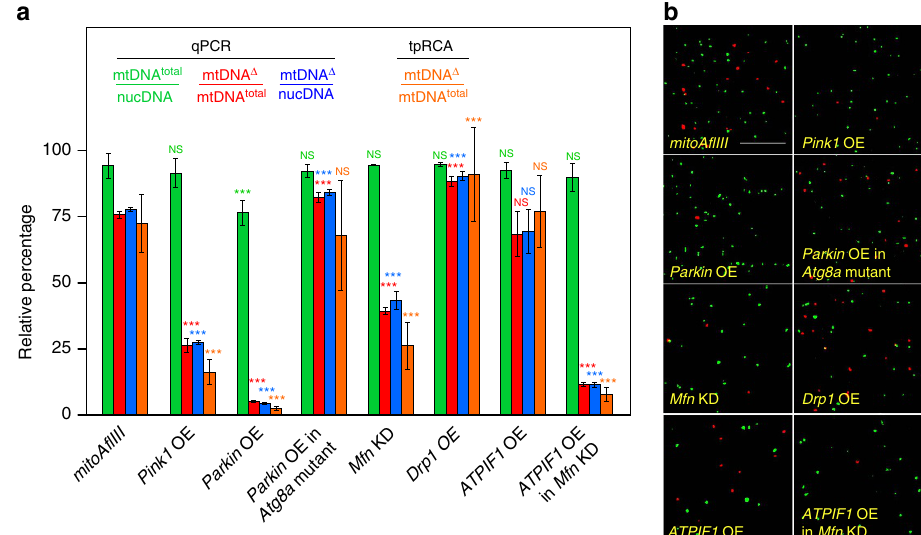
Figure 6 | Effects of manipulating PINK1/Parkin and Mfn and ATPIF1 on mtDNA D levels. ( a ) Relative abundance of different mtDNA species determined by qPCR and tpRCA. Bars depict mean ± 1 s.d. ( b ) Images from flight muscle of the indicated genotypes, hybridized for tpRCA as in Fig. 3. Scale bar, 10 m M. Statistical significance is estimated as compared with levels of the corresponding species in mitoAflIII flies using Student’s t- test with unequal variance. NS P 4 0.05 and *** P o 0.001. ( a , b ) Note that all data derives from Supplementary Table 3. Part of this, the mitoAflIII qPCR data, and the mitoAflIII tpRCA panel, are presented here and in Fig. 5 to facilitate comparison across genotypes, in particular with P{ pIFM-mitoAflIII, pIFM-mitoT4lig, pIFM-Gal4 }attP1 ( mitoAflIII ) flies in an otherwise wild-type background. Note that as in Fig. 5, total number of nucleoids labelled in each sample in b is not reflective of total muscle mtDNA levels, which are estimated using qPCR. NS, not